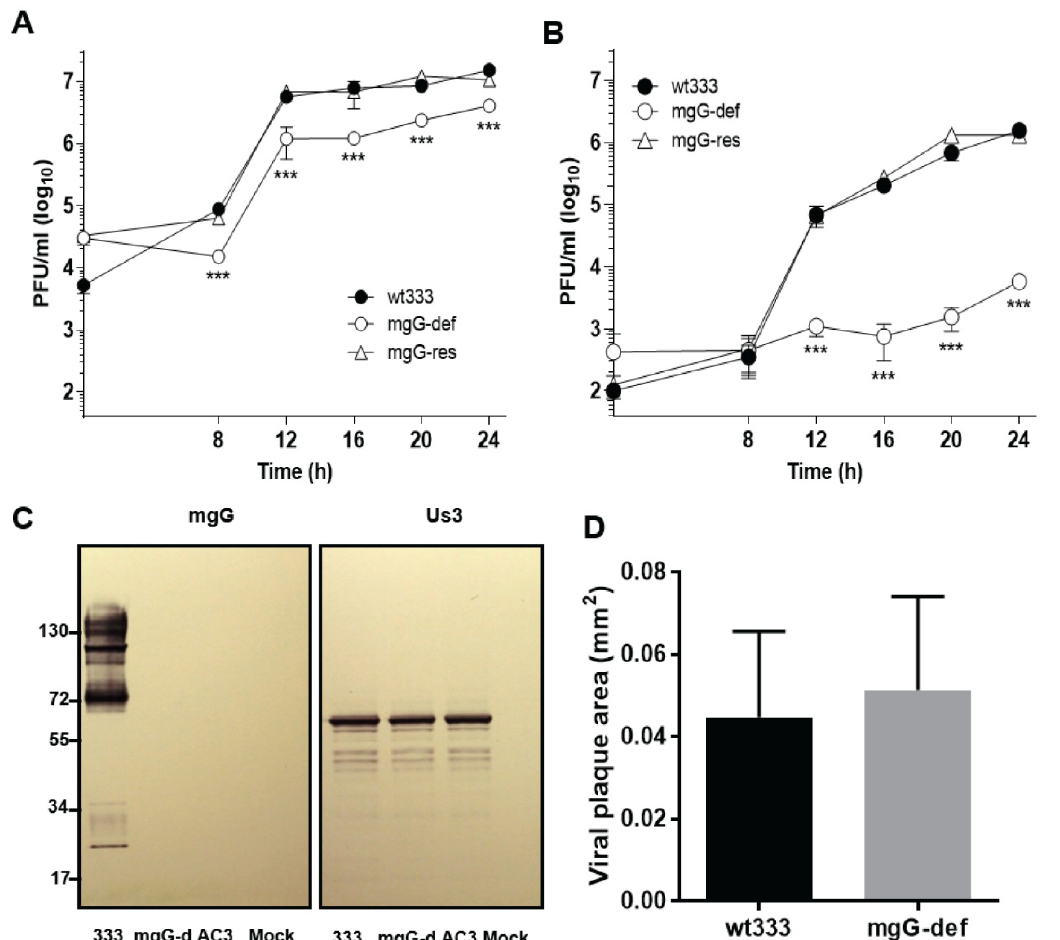
Figure 1. Biological activities of the mgG deficient HSV-2. One-step growth kinetics of the HSV-2 strain 333 (wt333), the mgG deficient recombinant virus (mgG-def), and the mgG-proficient (mgG-res) recombinant virus production in cells ( A ) and in infectious culture supernatant ( B ) of GMK AH1 cells. Values shown are means ( ± SD) of data from two separate experiments performed in duplicates. Statistically significant differences as related to wt333 at p values of <0.005 (***). ( C ) Expression of Us3 protein kinase by the mgG deficient HSV-2. Lysates of GMK AH1 cells infected with wt333 or the mgG deficient HSV-2 mutant viruses mgG-def (mgG-d) or 333 + AC3gG (AC3) were electrophoresed under reducing conditions on a 4–12% NuPAGE Bis-Tris precast gel and electroblotted into PVDF. Viral mgG and Us3 components were detected using monoclonal anti-mgG antibody O1C5 and rat polyclonal anti-Us3 serum respectively. ( D ) Areas of plaques formed by wt333 and the mgG-def mutant virus. The results are shown as the mean size ( ± SD) of 67 viral plaques captured at 48 h after infection of GMK AH1 cells from six different microscope